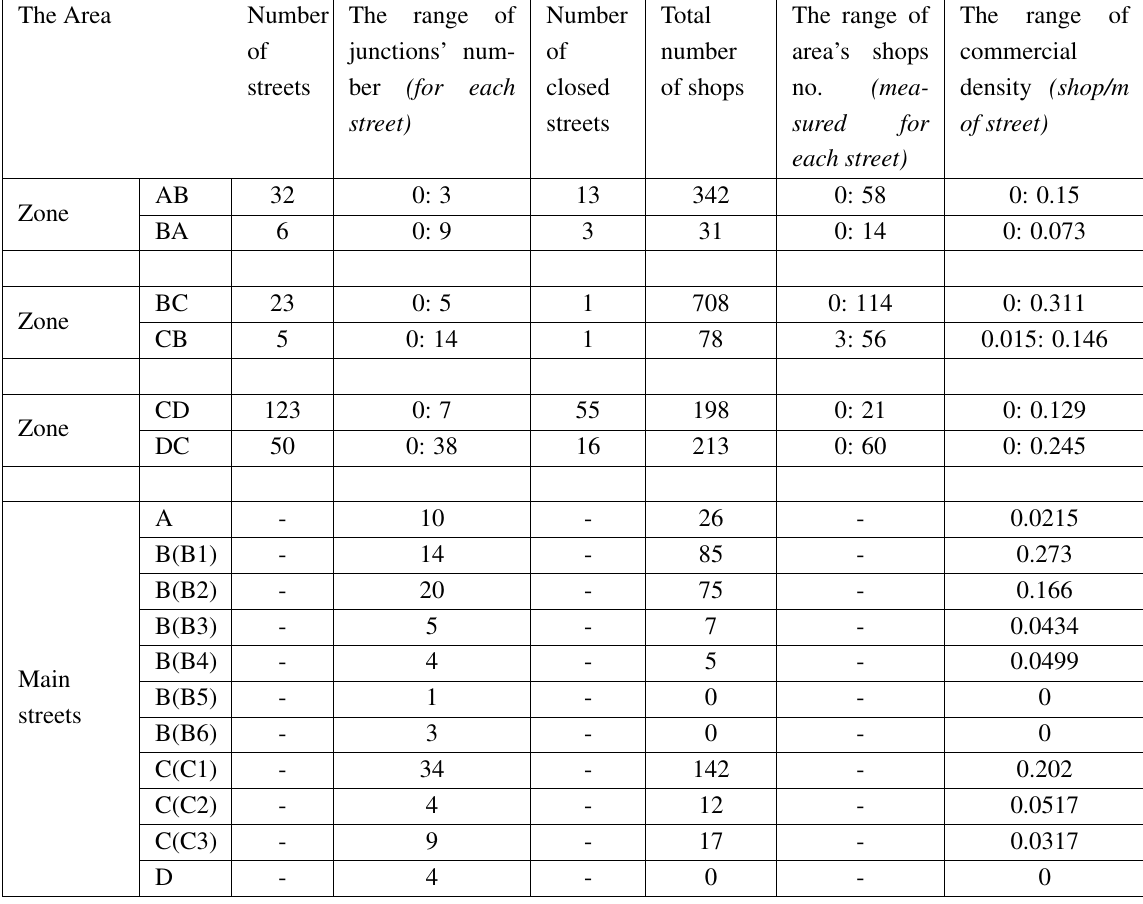
Table 1. Overview of the case study